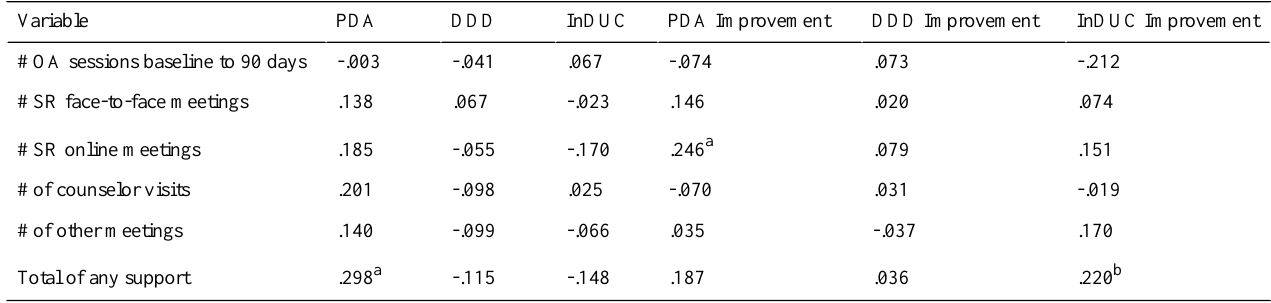
Table 3. Correlations between various resources available and outcome variables at 3 months, significant relationships